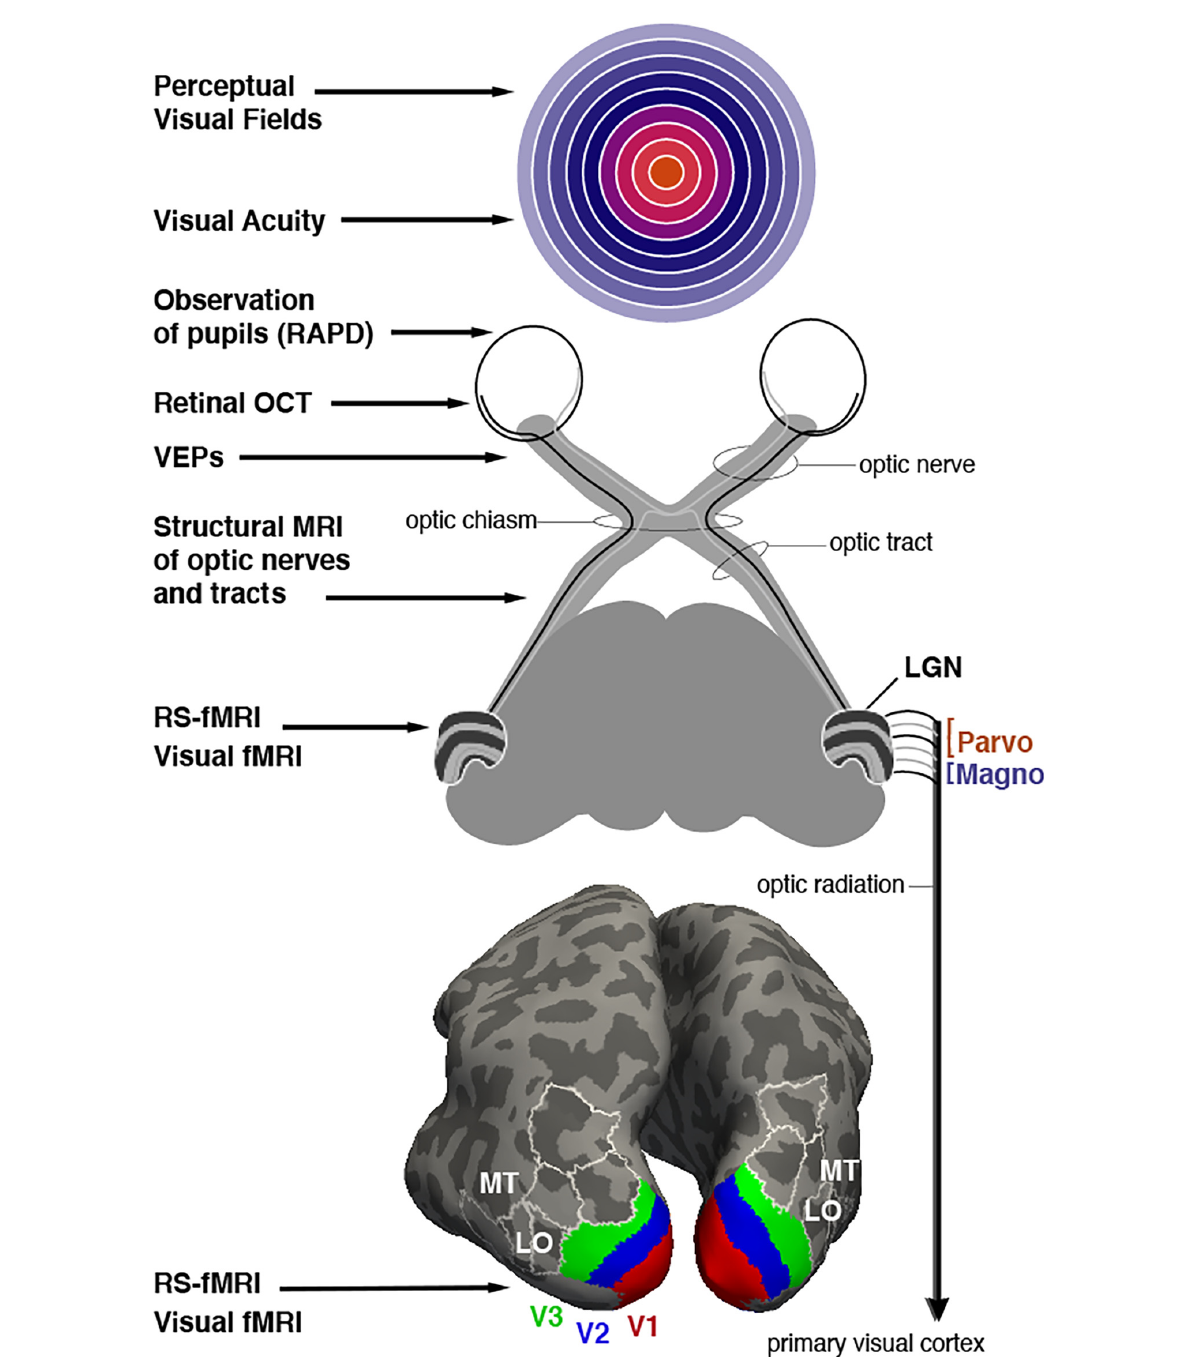
FIGURE1 Assessment of optic neuropathy at different levels of the visual system. Potential ophthalmological tools are listed that rely on behavioral testing, clinical observation, microscopy, electrophysiology or MRI imaging (on left). Top image : Representation of the visual field with (foveal) central vision colored orange, mid-eccentricities colored with cooler hues, and peripheral locations colored with increasingly light purple. White rings represent eccentricities spanning from 10 to 90 degrees in 10 degree increments. Middle image : Schematic description of retinal projections to the thalamic lateral geniculate nucleus (LGN). LGN is shown with layers 1–6 that segregate input from each eye (contra, ipsi, ipsi, contra, ipsi, contra). Layers 1 and 2 form the magnocellular projections to V1 while layers 3–6 comprise the parvocellular input. Bottom image : Inflated depiction of cerebral cortex, posterior view. A probabilistic brain atlas (Wang et al., 2015) is used to show the location of several retinotopically organized visual areas. Lower-tier areas V1, V2, and V3 are shown with red, blue, and green, respectively. Some additional higher-tier areas are indicated as well, in particular areas MT and LO (LO1 and LO2) mentioned in the text as well. White outlines, included for context, localize area V3A, V3B, IP0 (dorsally), and V4v, VO1, VO2